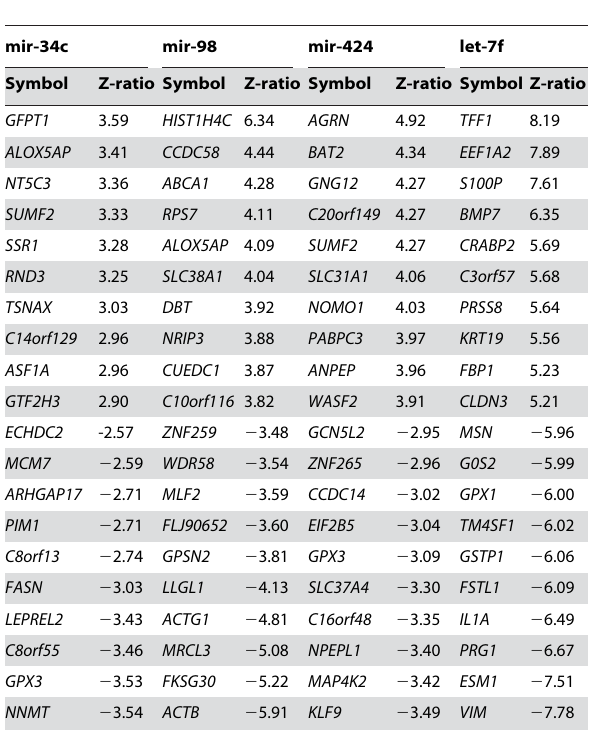
Table 4. Top 10 up-regulated and down regulated genes after over expression of mir-34c, mir-98, mir-424 and let-7f in UCI-101 cell